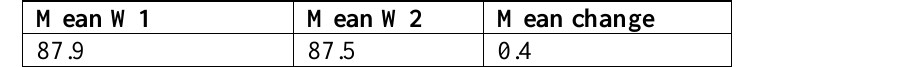
Table 11: shows the weight status in 15 patients with increase in the TSH after 2 months.(W 1 =initial weight, W 2= weight after metformin).